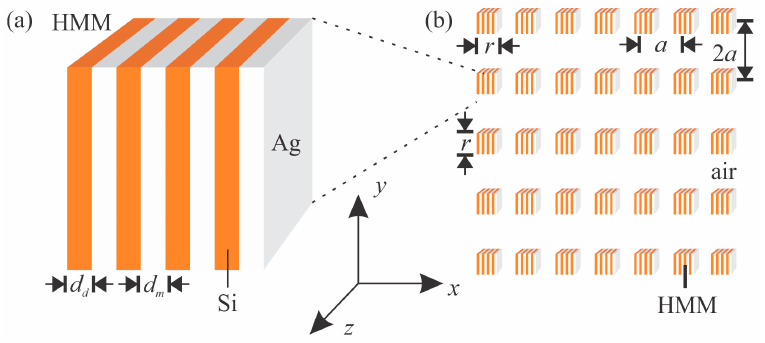
Figure 1. Sketch of ( a ) an HMM consisting of Si and Ag layers, and ( b ) a 2D PHC containing HMM rods.